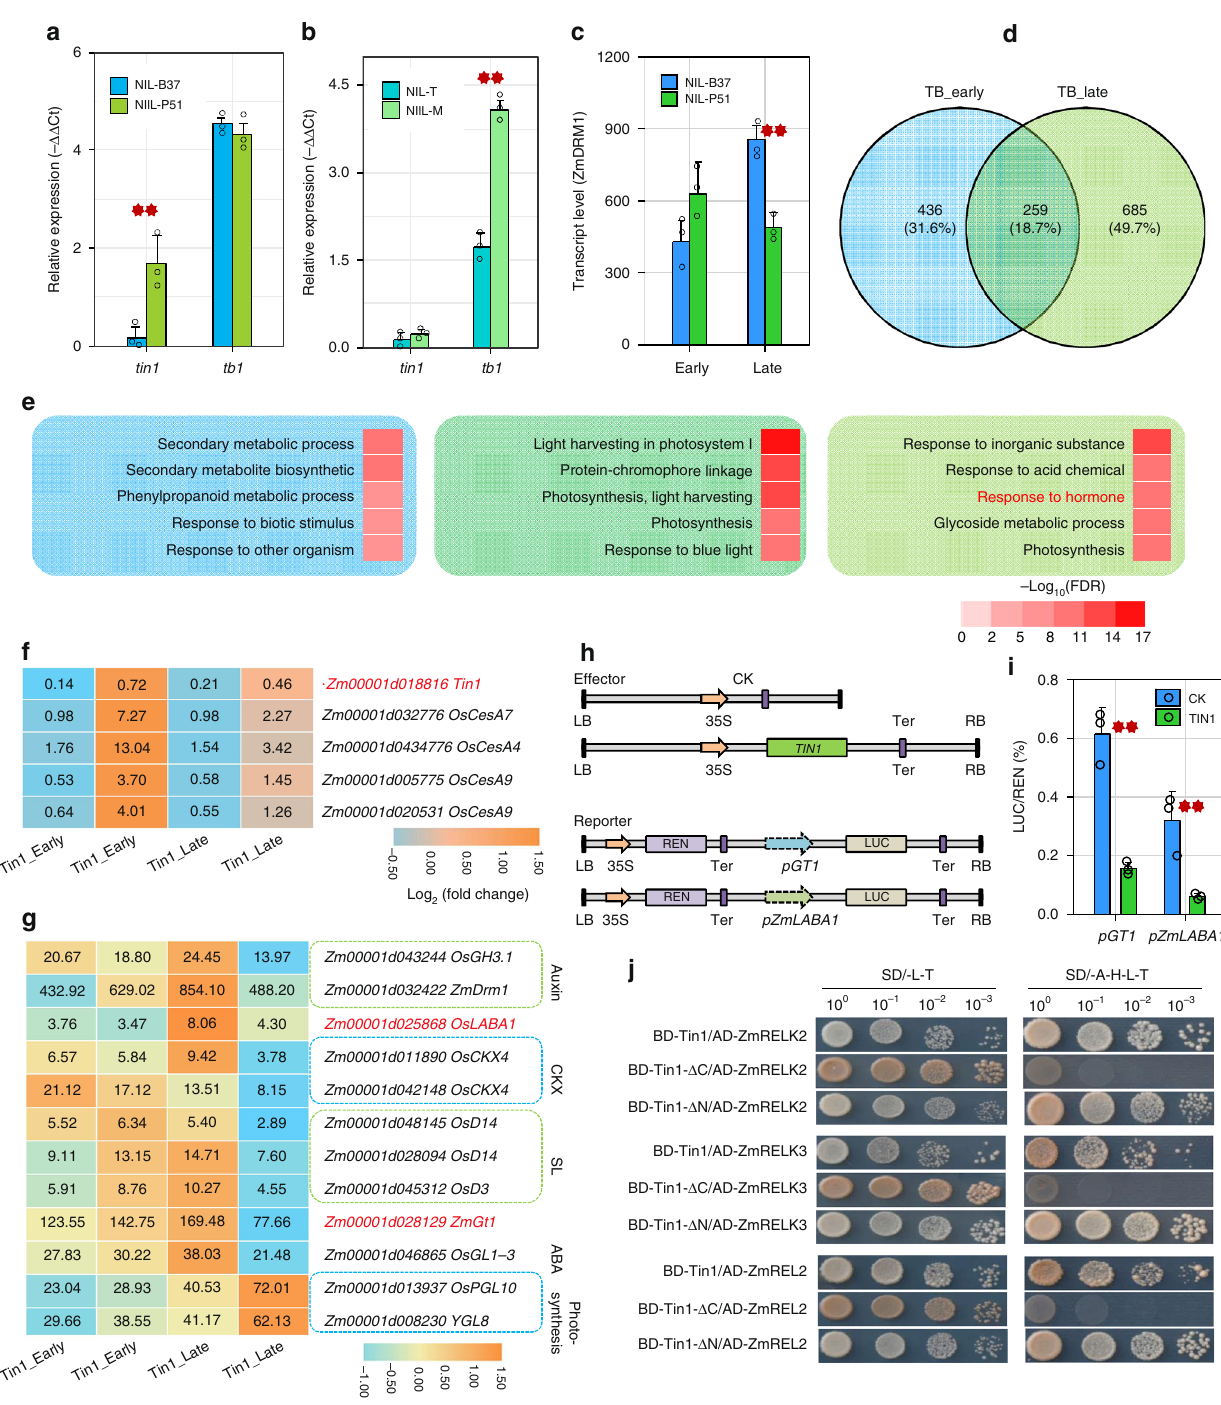
TOPLESS 22 (TPL) and TPL-related proteins (TPRs) 23 have been reported to function as co-repressors in various plant hormone signaling and tiller developmental pathway. The EAR motif is a hallmark of the TPL and TPR interacting proteins 22,23 . There are four TPL/TPR/REL genes expressed in maize tiller bud, namely RELK1 (Zm00001d040279), RELK2 (Zm00001d028481), RELK3 (Zm00001d047897) and REL2 ( RAMOSA1 ENHANCER LOCUS2 24 , Zm00001d024523) 24 (Supplementary Fig. 13). Only RELK1 showed low expression level in maize tiller bud (Supplementary Fig. 13). In rice, the homolog of REL2